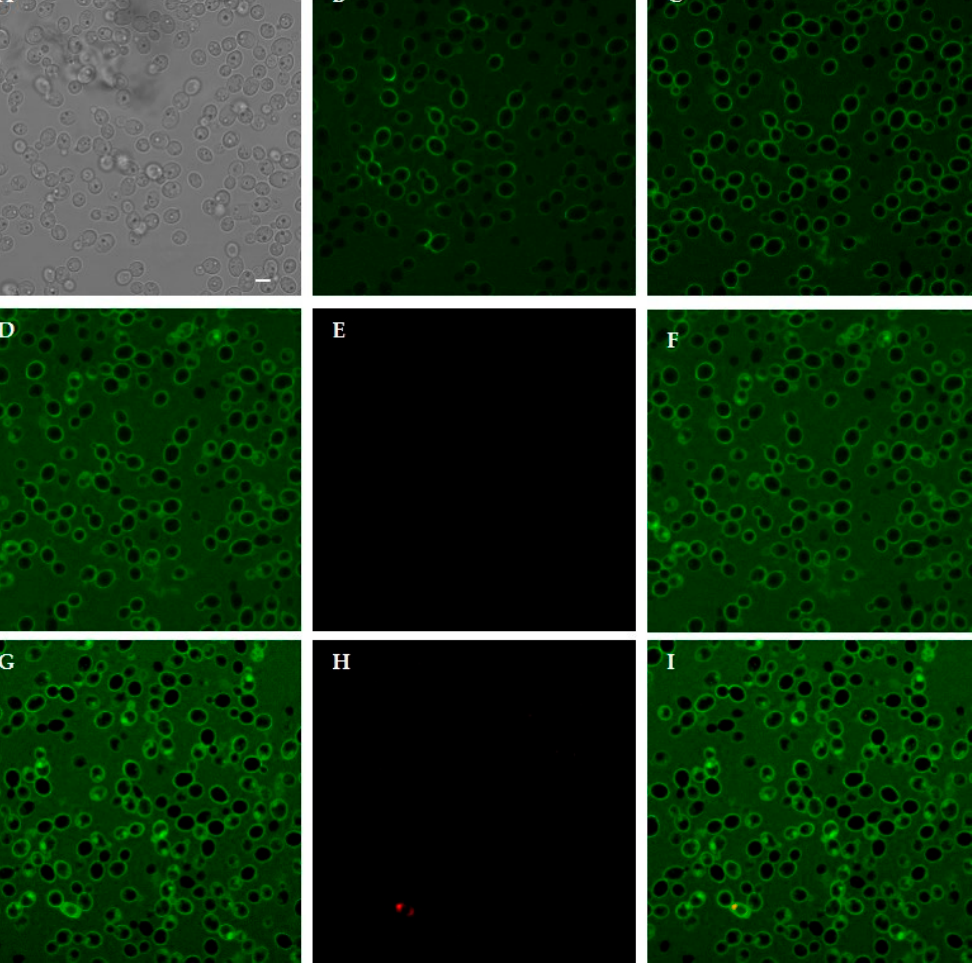
Figure 8. Interaction between living Candida albicans cells and FITC-labeled KP. Confocal microscopy images of yeast cells incubated for 10 min and 150 min with the labeled peptide are shown in ( B , C ), respectively. KP bound to yeast cell wall. In ( A ), the same field is shown in light transmission. Peptide internalization was observed after 240 min: ( D ) FITC; ( E ) PI; ( F ) merge of ( D , E ) and increased over time leading to cell death, as demonstrated by PI internalization after 360 min: ( G ) FITC; ( H ) PI; ( I ) merge of ( G , H ). Bar, 5 µm.